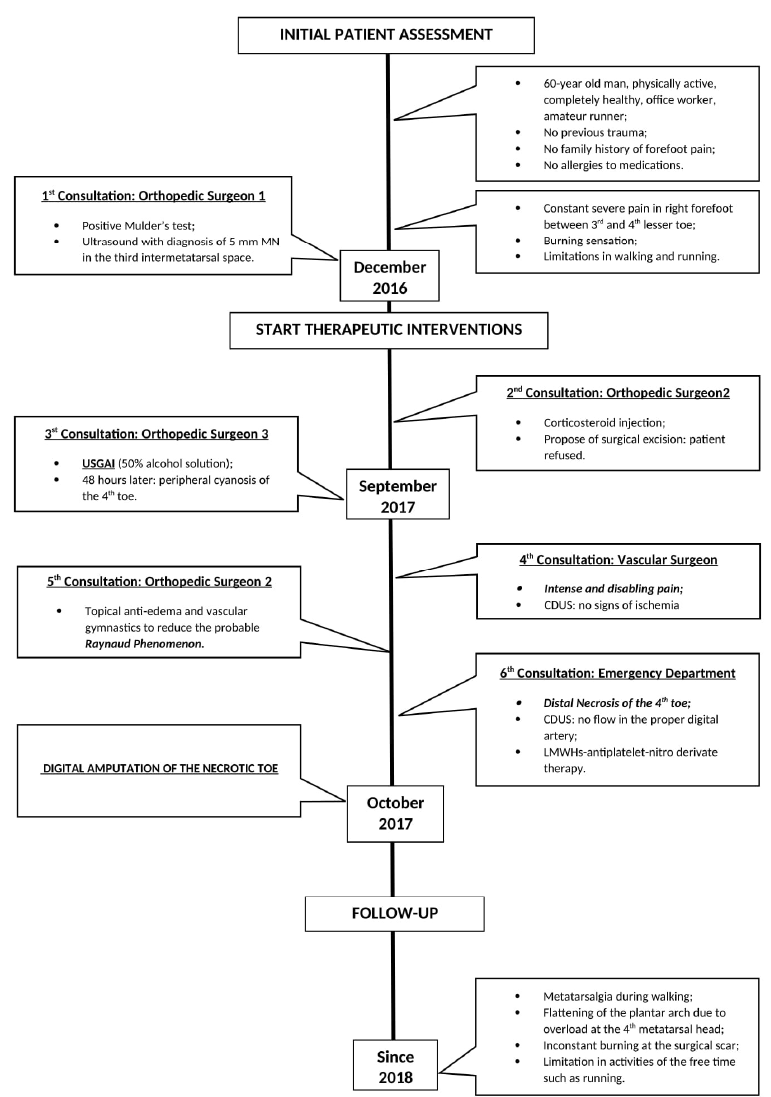
Figure 1. The Flow Chart of the Case